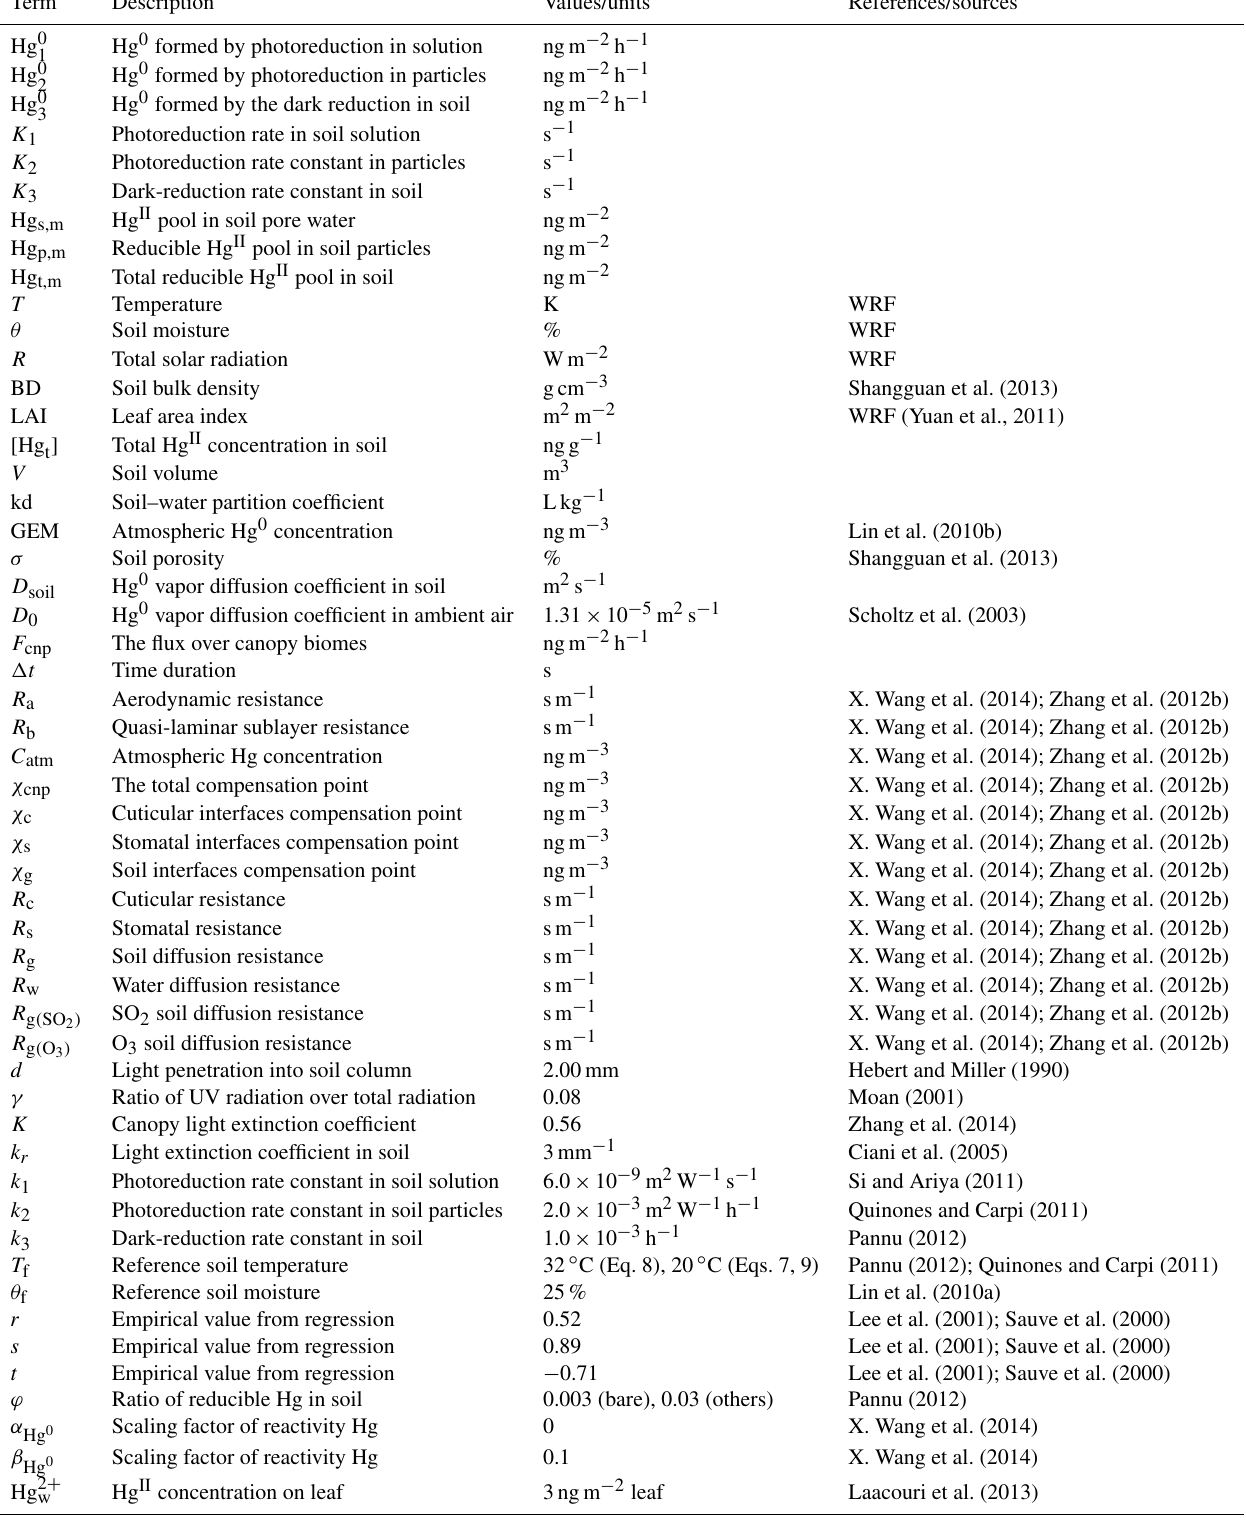
Table 1. Model variables, constants, and rate coefficients used in the model simulation.